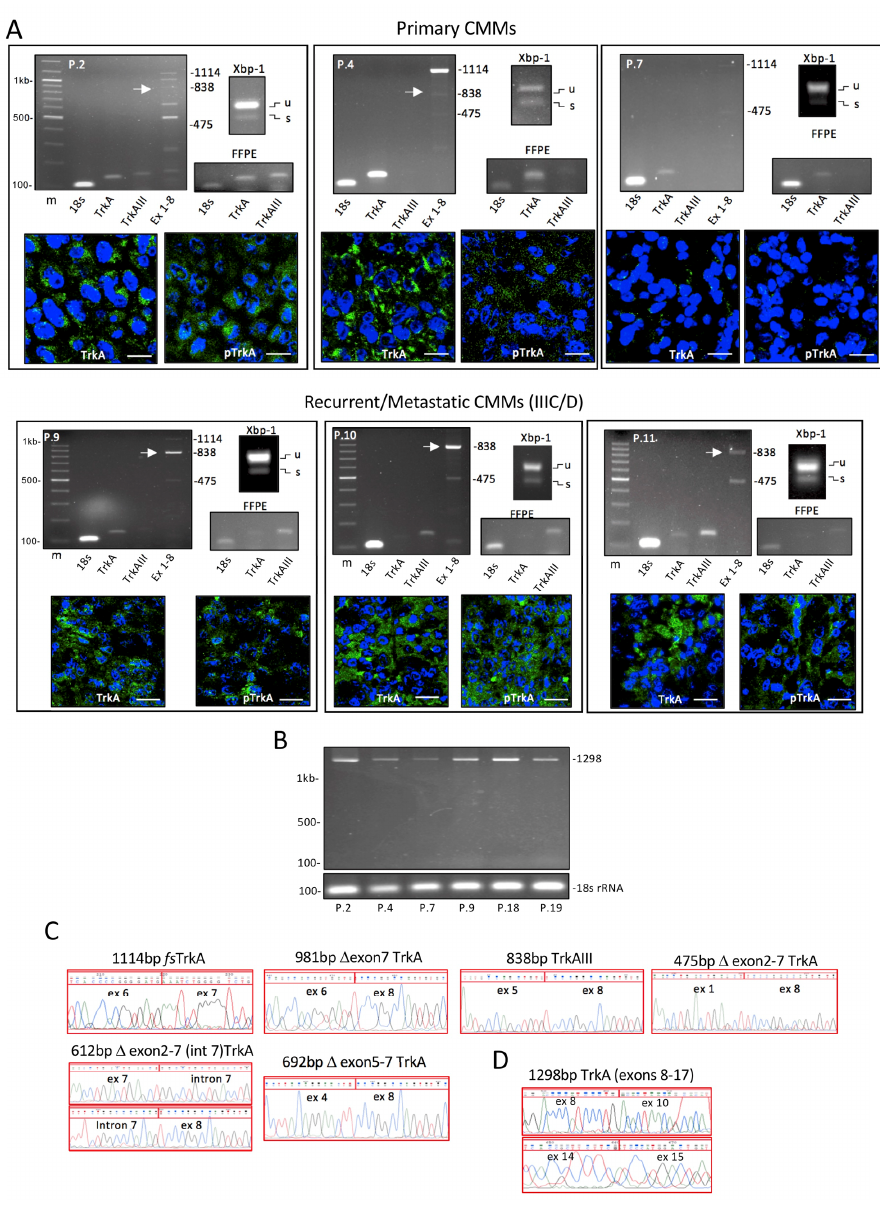
Figure 1. Alternative TrkA mRNA splicing, unconventional Xbp-1 splicing and TrkA and phosphorylated TrkA isoforms in CMMs. ( A ) Representative RT-PCRs, demonstrating 18S rRNA, TrkA, TrkAIII, TrkA exon 1–8 splice (Ex 1–8) alternative splice variants, and unspliced (u) and unconventionally spliced Xbp1 (s) RT-PCR products, in RNAs from 3 snap-frozen primary (P.2, P.4 and P.7) and 3 snap- frozen metastatic CMMs (P.9, P.10 and P.11), and in corresponding formalin-fixed paraffin-embedded (FFPE) tissues (m = DNA markers). Accompanying IF micrographs demonstrate immunoreactivity for TrkA, using the rabbit polyclonal anti-TrkA (C14) antibody (TrkA, green), and for phosphorylated TrkA, using the rabbit monoclonal anti-phosphorylated Y490 TrkA (9141) antibody (pTrkA, green), with DAPI-stained nuclei (blue), in each CMM (bar = 10 µ m). ( B ) RT-PCRs demonstrating 18S rRNA and TrkA exon 8–17 RT-PCR products in a representative selection of CMMs. ( C ) DNA sequences of RT-PCR products generated by TrkA exon 1–8 primer sets, confirming the presence of splice junction sequences consistent with fully spliced ( fs ) TrkA, ∆ exon 7 TrkA, TrkAIII, ∆ exon 2–7 TrkA, ∆ exon 2–7(int 7) TrkA and ∆ exon 5–7 TrkA ( ∆ = skipped exon(s), and ( D ) TrkA sequence generated by TrkA exon 8–17 primer sets in the single product detected in CMMs, exhibiting exon 9 skipping consistent with the TrkAI